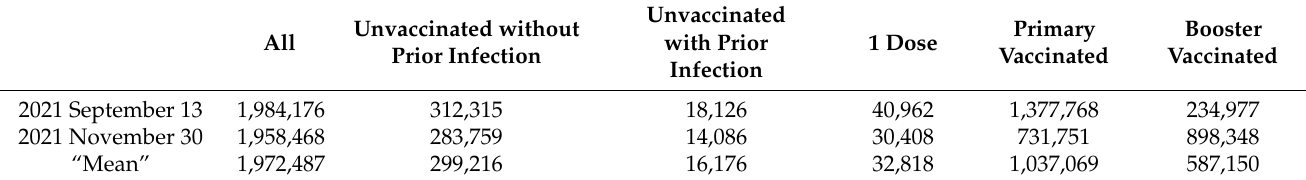
Table 1. The change in distribution of the population by vaccination during the study period